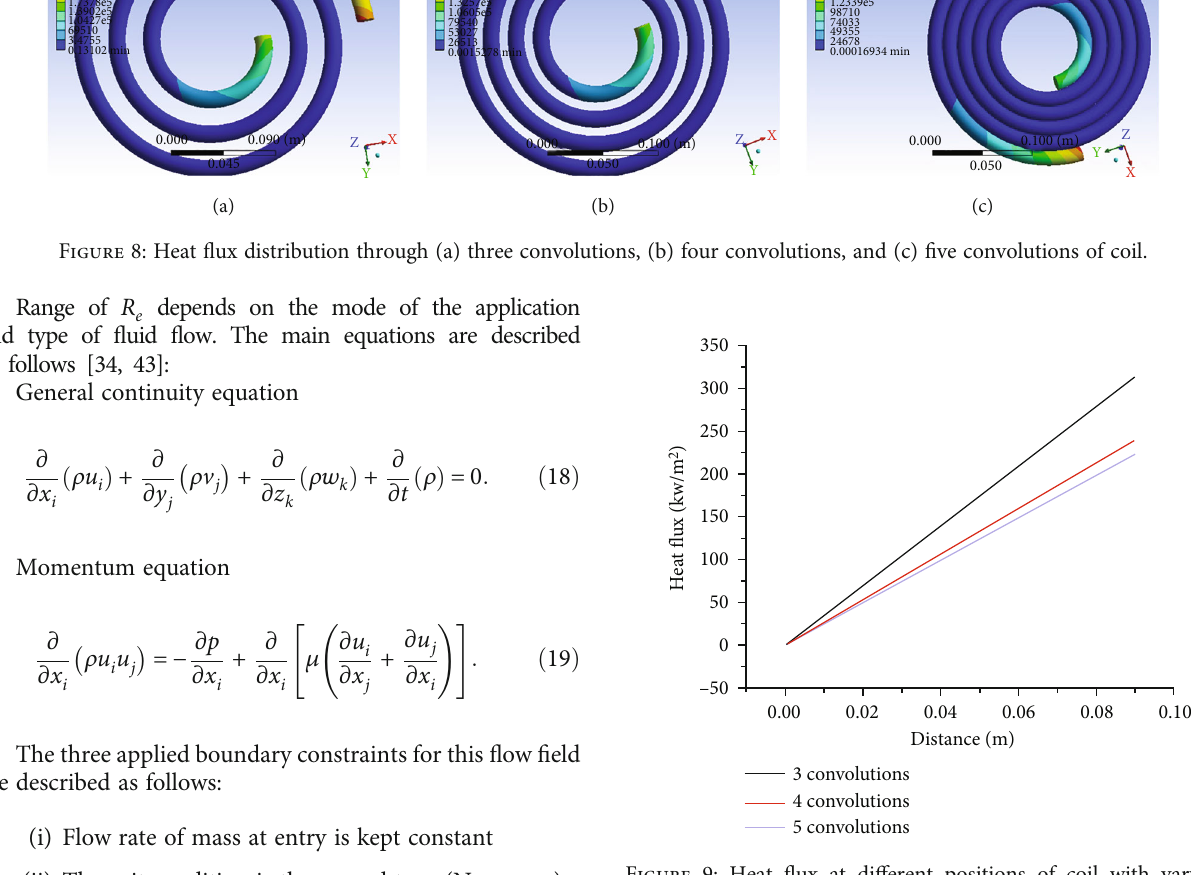
Figure 9: Heat fl ux at di ff erent positions of coil with varying number of